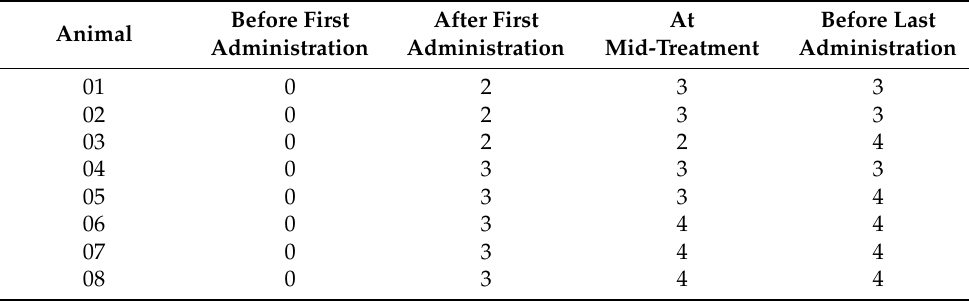
Table 3. Increased motor unit activity for each animal at a different time